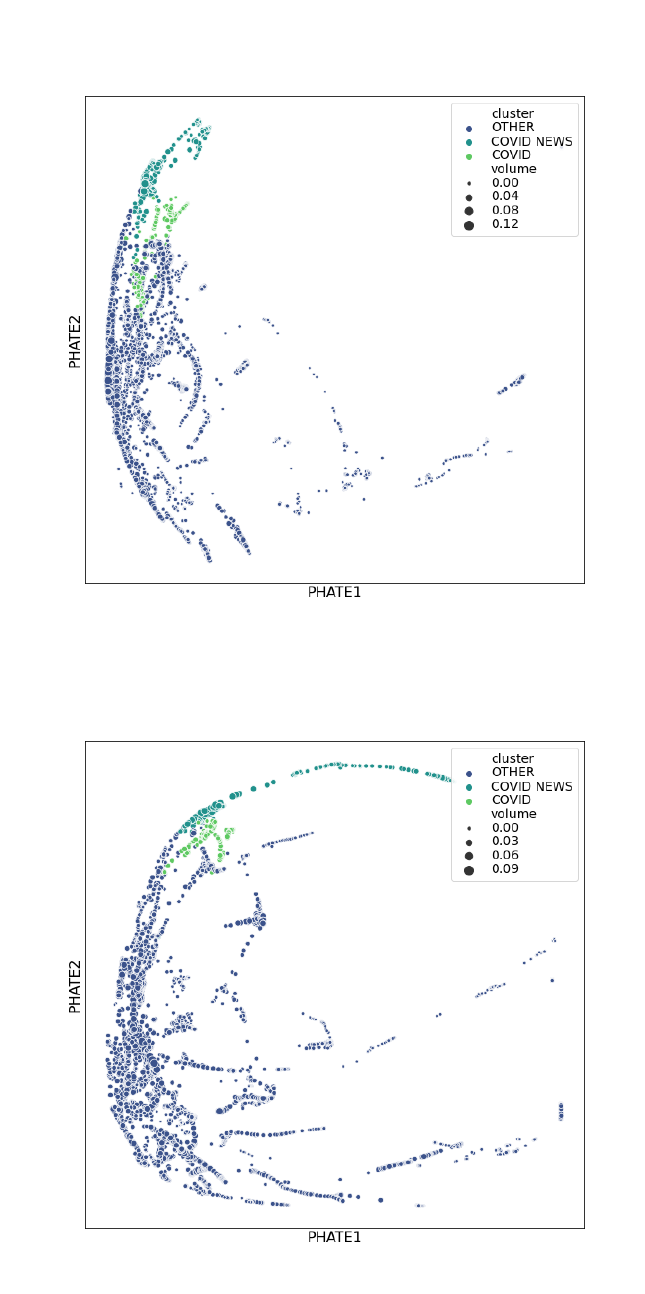
Figure H.3. Potential of heat-diffusion for affinity-based transition embedding (PHATE) for all word distributions. The topics here are learned by T-LDA on tweet collections constructed with smoothing parameters 0 . 65 (top) and 0 . 85 (bottom). Here two clusters and one shortest path are highlighted for comparison with Figure 4. Note that the overall structures as well as the trajectories for highlighted points are similar in all three cases, while the lengths of the trajectories are different, which are the result of different assumptions on the range of the temporal dependence (i.e., a smoothing using 0 . 85 assumes longer range dependence by including more old